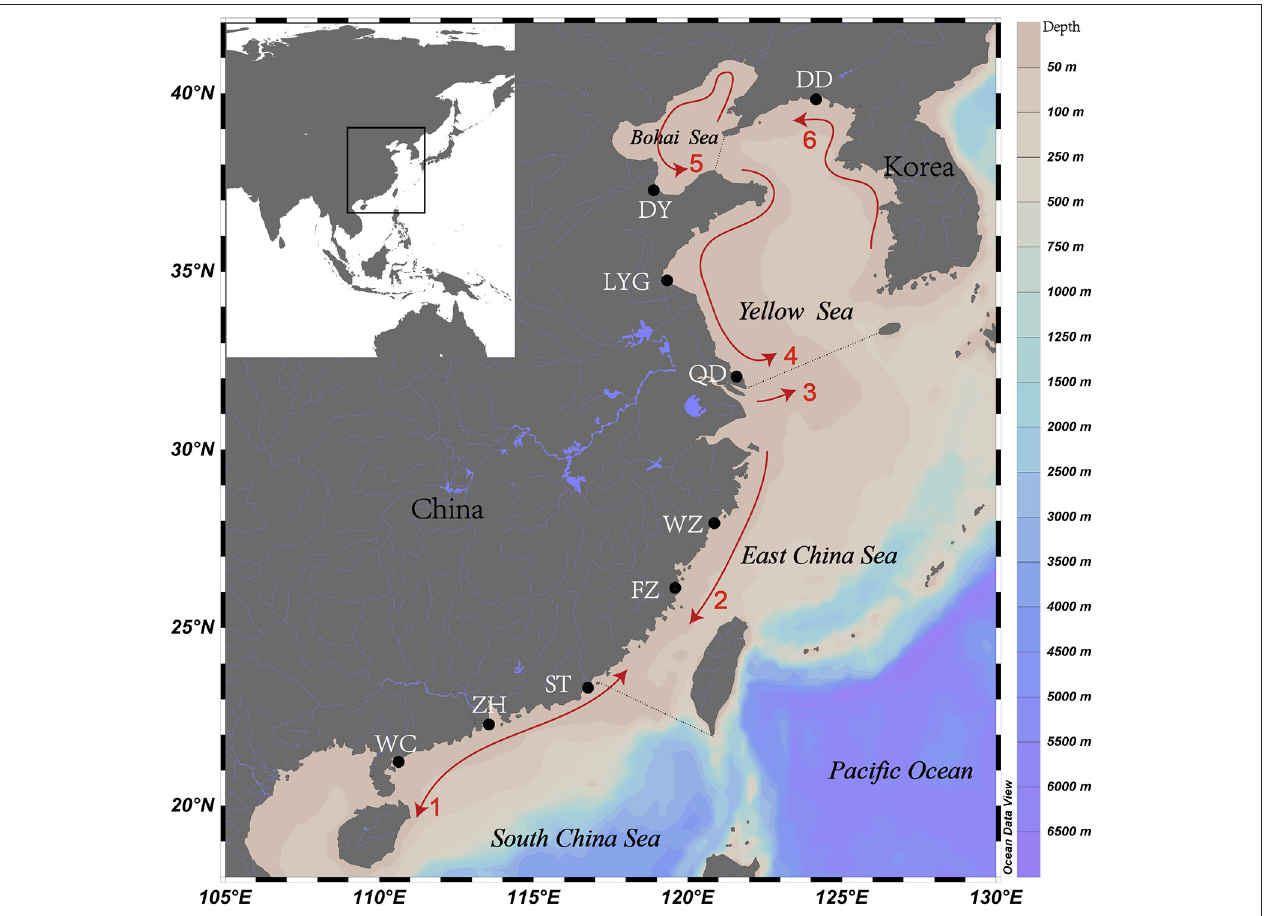
FIGURE 1 | Sampled estuaries for spinyhead croaker Collichthys lucidus in Chinese coastal waters. Black dots represent the sampled estuaries: DD, Yalu River Estuary; DY, Yellow River Estuary; LYG, Haizhou Bay; QD, Yangtze River Estuary; WZ, Oujiang River Estuary; FZ, Minjiang River Estuary; ST, Hanjiang River Estuary; ZH, Pearl River Estuary; and WC, Jianjiang River Estuary. Arrows indicate the spreading direction of coastal currents: 1, Guangdong Coastal Current (GCC); 2, Zhejiang–Fujian Coastal Current (ZFCC); 3, Yangtze Diluted Water (YDW); 4, Yellow Sea Coastal Current (YSCC); 5, Bohai Sea Coastal Current (BSCC); and 6, Korea Coastal Current (KCC). The coastal current system diagram is a composite mainly based on reference ( Chen et al., 1991). Water depths are shown in different colors. For interpretation of the color references in this figure legend, the reader is referred to the Web version of this